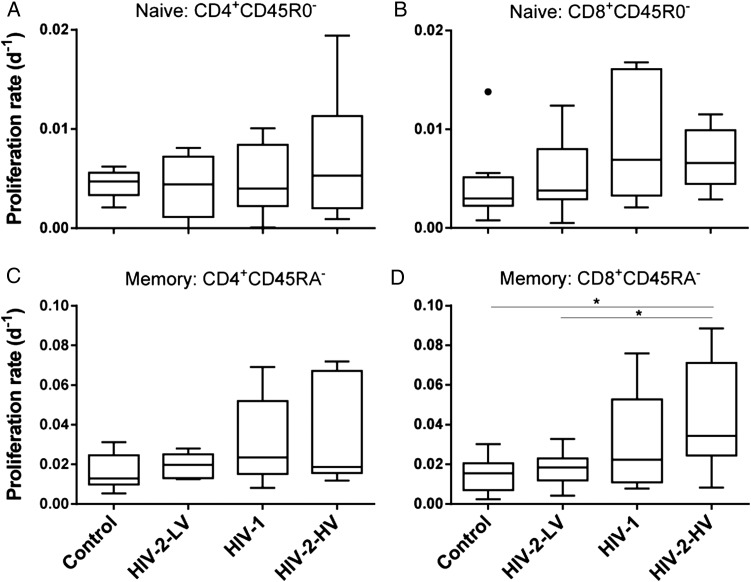
Proliferation rates of T-cell subpopulations in controls and HIV infection. Modeled proliferation rate constants (p) in CD4+ and CD8+ T-cell subpopulations for (A) CD4+CD45 R0− and (B) CD8+CD45 R0− “naive” cells; and (C) CD4+CD45RA− and (D) CD8+CD45R0A− “memory” cells. Line, box, and whiskers represent median, IQR, and range, respectively; outliers shown as dots using Tukey criteria. Note different scales for naive and memory cells. There was a significant trend across groups for CD4+ and CD8+ memory cells (P < .006, .001, respectively), but not for naive cells. Specific group differences tested by ANOVA: naive cells, not significant; memory cells, P = .047, .010, for CD4+ and CD8+, respectively; *P < .05 by post hoc test. Abbreviations: ANOVA, analysis of variance; HIV, human immunodeficiency virus; HIV-2-HV, HIV-2 infected with high viral load (>1000 copies/mL); HIV-2-LV, HIV-2 infected with low viral load (<100 copies/mL); IQR, interquartile range.